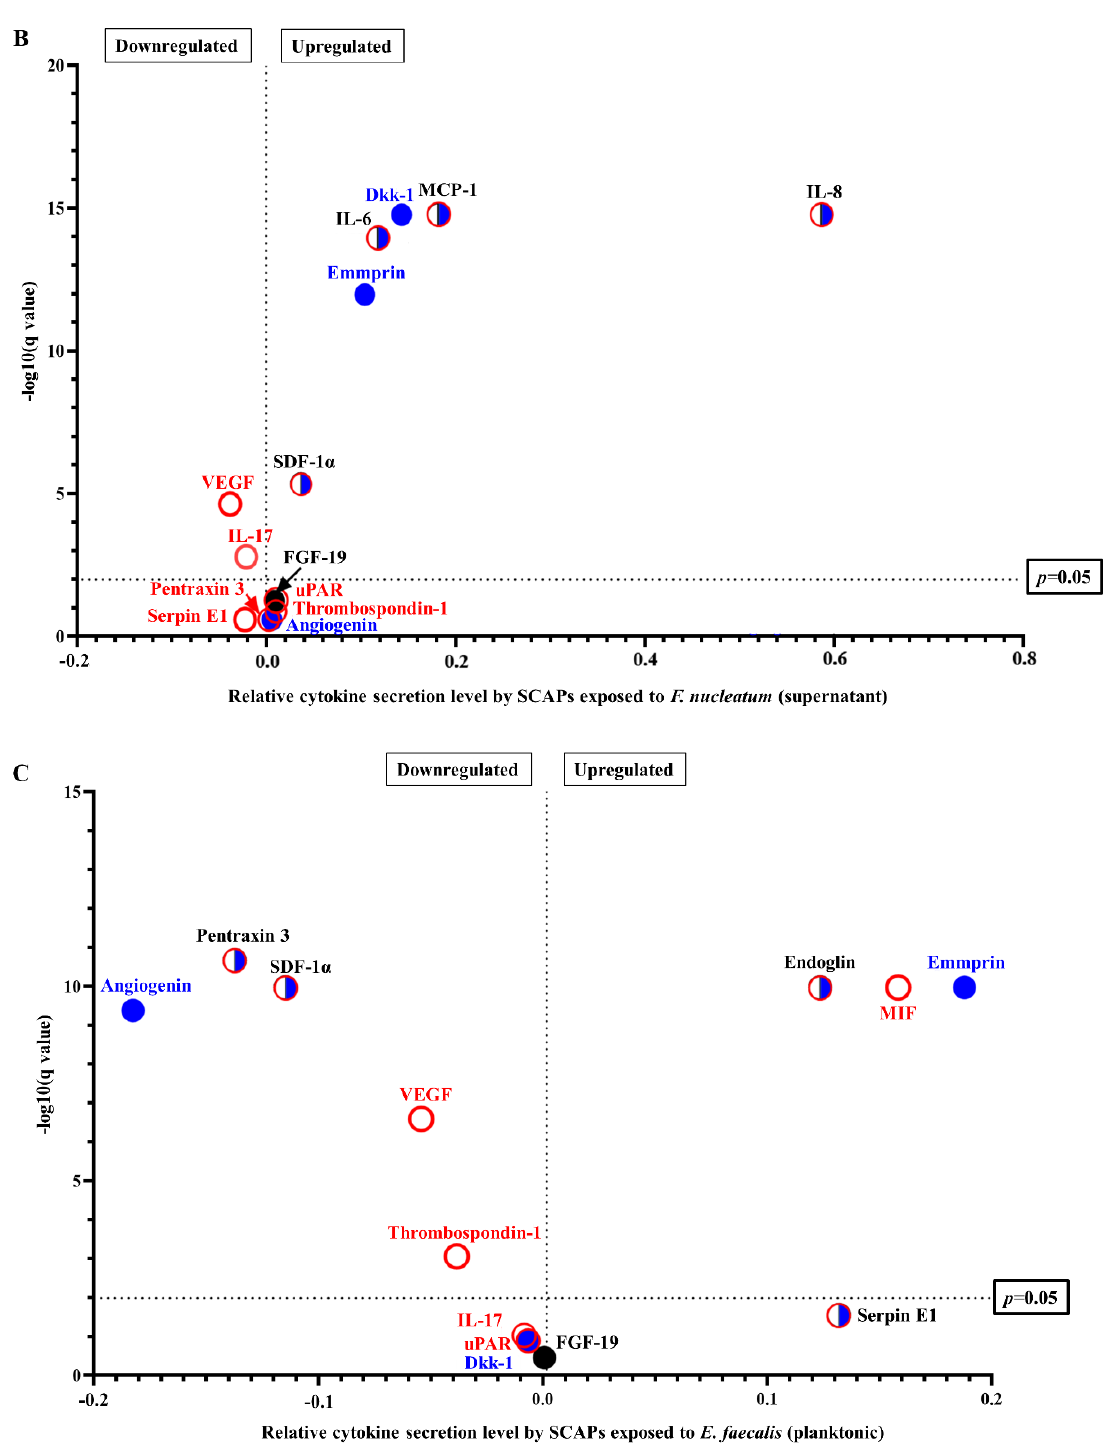
Figure 2. Immunomodulatory- and osteogenesis-related chemokine and cytokine levels by SCAP modulated by oral species. Volcano plots representing SCAP modulated by viable ( A ) F. nucleatum (planktonic), ( B ) F. nucleatum supernatants, or ( C ) viable E. faecalis (planktonic). Osteogenesis-related cytokines are marked by circles filled with blue; immunomodulatory-related cytokines are marked by empty circles with red borders; cytokines that can play a role in osteogenesis and in immunomodulation are marked by half-blue and half-white circles with red borders; cytokines with a function related to other processes are marked by circles filled with black.